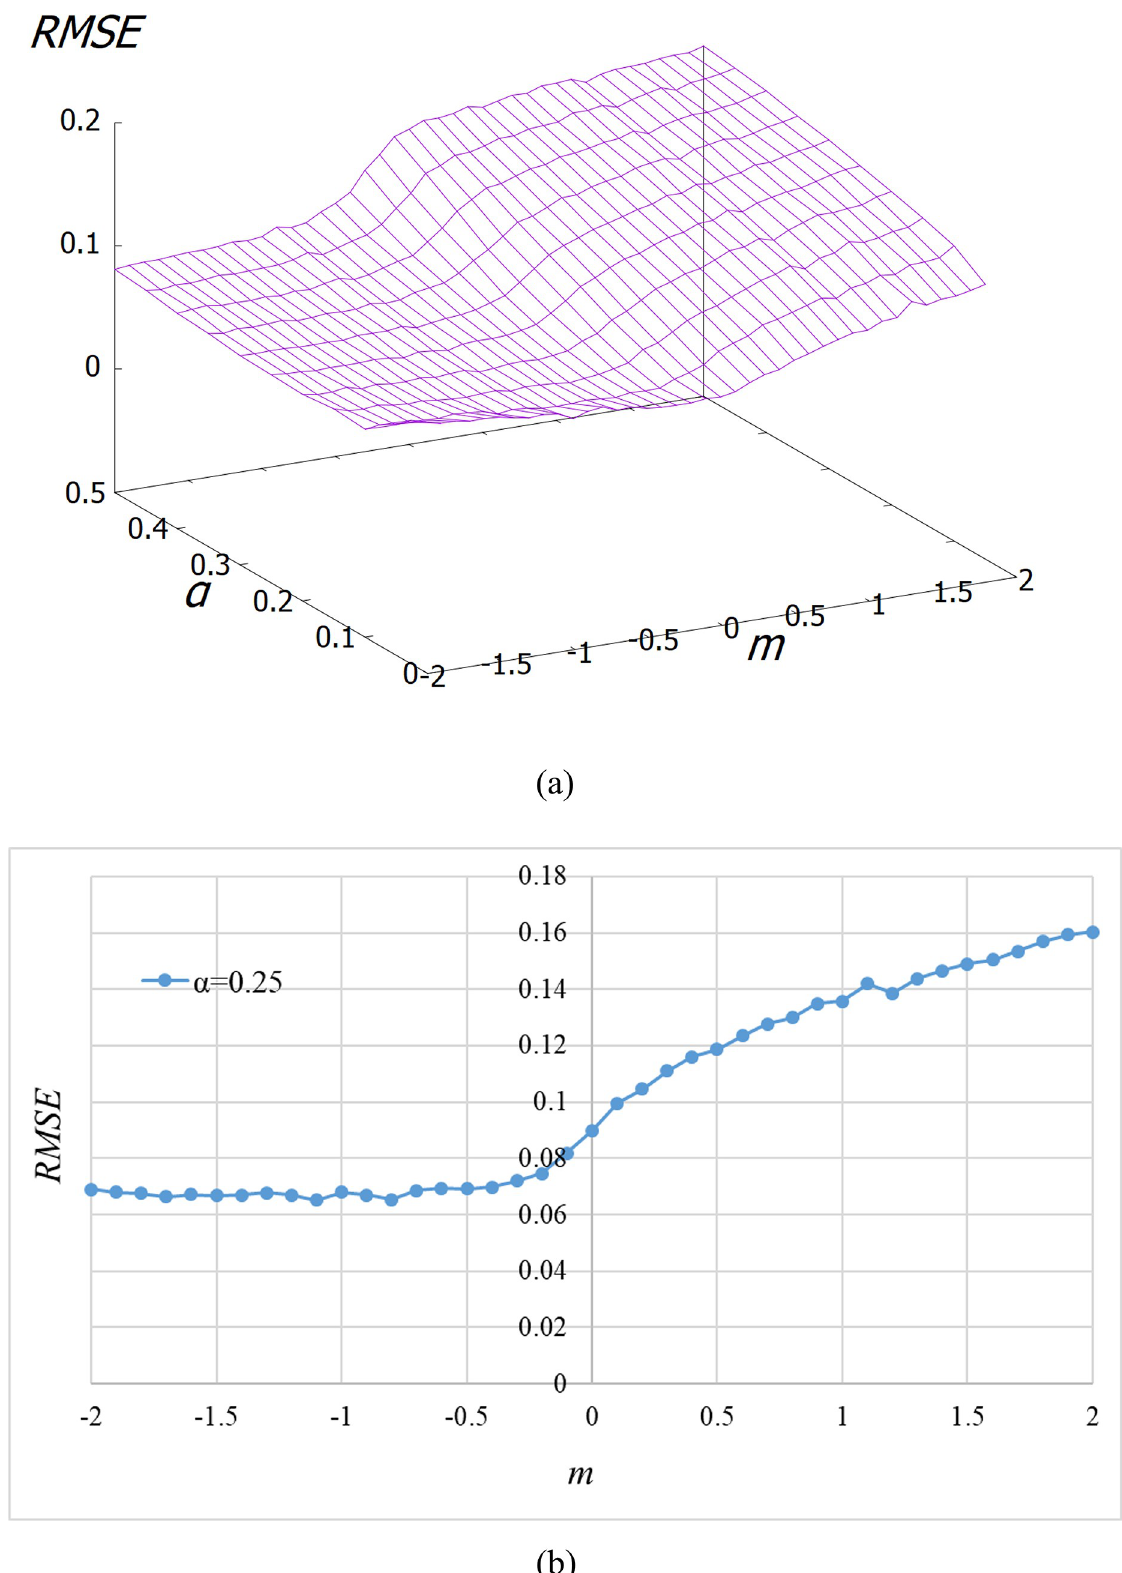
Fig 7. RMSE for each pair of parameter values. (a) In all cases. (b) In the case of α = 0.25. https://doi.org/10.1371/journal.pone.0233559.g007 PLOS ONE | https://doi.org/10.1371/journal.pone.0233559 May 22,